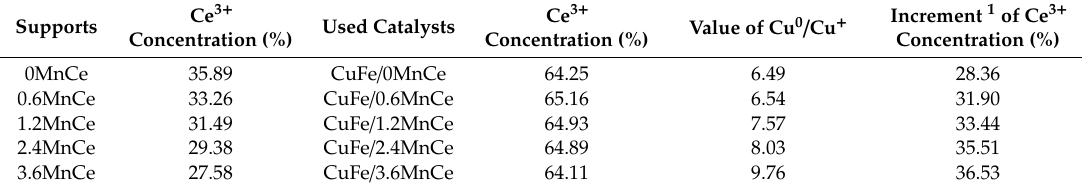
Table 1. Ce and Cu compositions on the surface of supports and used